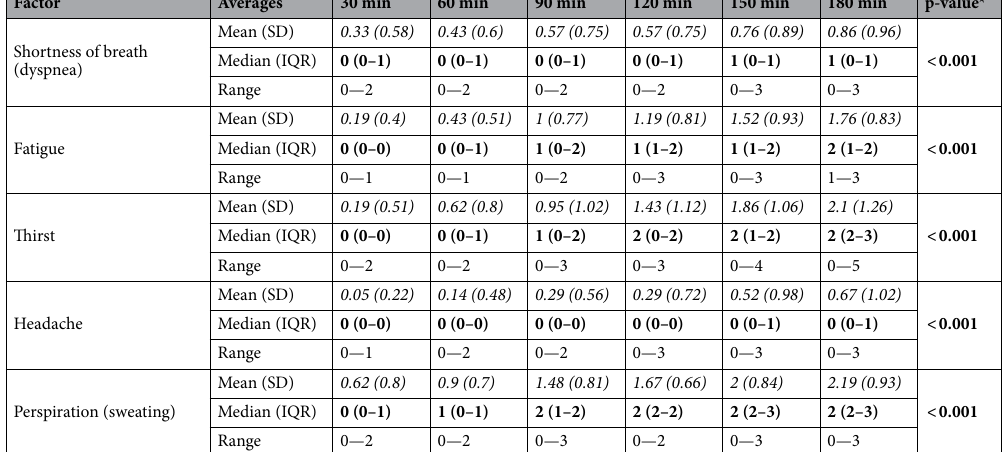
Table 4. Comparison of the different well-being markers between the 30-min time points and while working in the FFP3/PPE (n = 21). Results depicted in scoring scale (score range 0 to 6, see also Supplemental materials 1 for details). Significant values are in bold and italics. *Assessed by Friedman’s